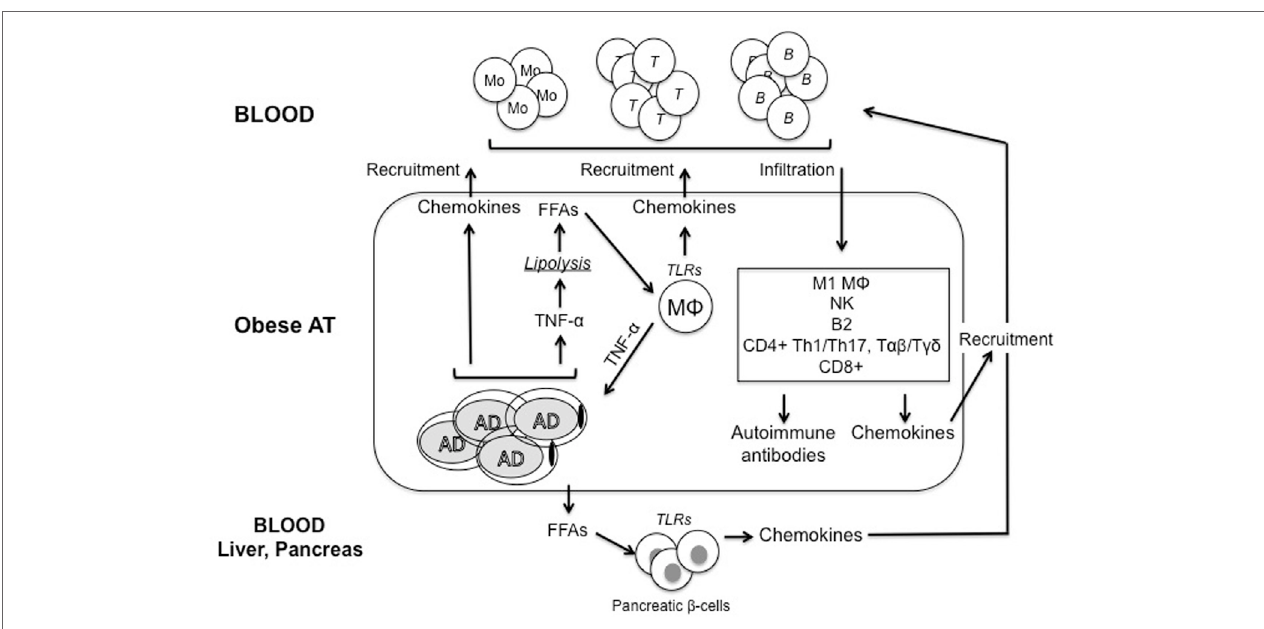
FiGURe 1 | Model for regulation of inflammatory pathways in the obese adipose tissue (AT). Adipocytes (AD) in the obese AT are highly inflammatory and secrete several pro-inflammatory cytokines and chemokines, which recruit immune cells, thus contributing to the establishment and maintenance of local and systemic inflammation. Among these inflammatory mediators, tumor necrosis factor (TNF)- α released by both AD and immune cells induces lipolysis and release of free fatty acids (FFAs), which activate tissue-resident macrophages (M Φ ) to release cytokines and chemokines. FFAs are also released in blood and cause both insulin resistance and inflammation in major insulin target tissues. Immune cells recruited to the obese AT differentiate into inflammatory subsets and secrete additional pro-inflammatory mediators. We hypothesize that these cells would generate suboptimal immune responses in obese individuals by circulating to peripheral lymphoid organs. Pathogenic antibodies may be secreted by B cells in the AT. These antibodies may form immune complexes with “self”-antigens, which in turn activate complement and Fc receptors on immune cells, leading to enhanced local inflammation, remodeling of the AT, impairment of adipocyte function and nutrient metabolism, and exacerbation of obesity-associated conditions. These antibodies can also exert additional detrimental effects both locally and systemically targeting distinct clusters of self proteins. One mechanisms for the release of “self”-antigens in the obese AT is the decreased supply of oxygen, resulting in areas of hypoxia, which leads to further release of pro-inflammatory cytokines, as well as to the release of “self”-antigens, such as intracellular proteins, cell-free DNA, and